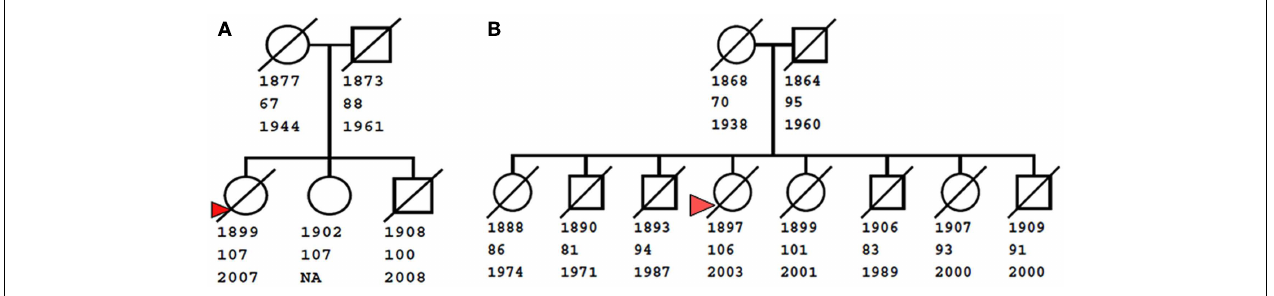
live past the age of 80. Squares and circles represent males and females, diagonal bars represent deceased subjects. Numbers below nodes are birth years, last age at contact, and death year. For living subjects, the death year is not available (NA). Red triangles denote probands enrolled in the New England Centenarian